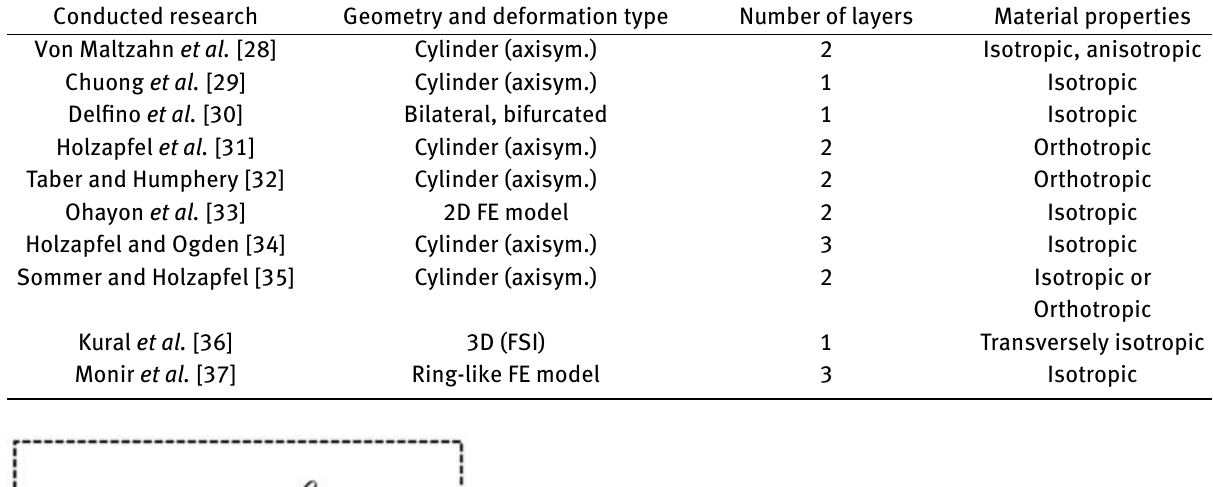
Table 3: A summary of computational models of arterial walls, and the applied material properties